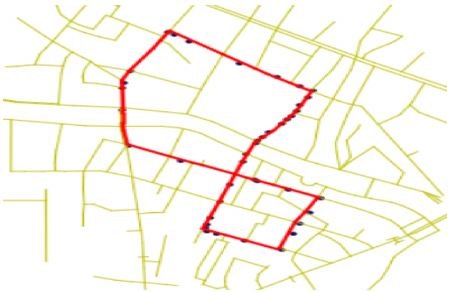
Figure 4. Map matching result of Bus Line 1022 route